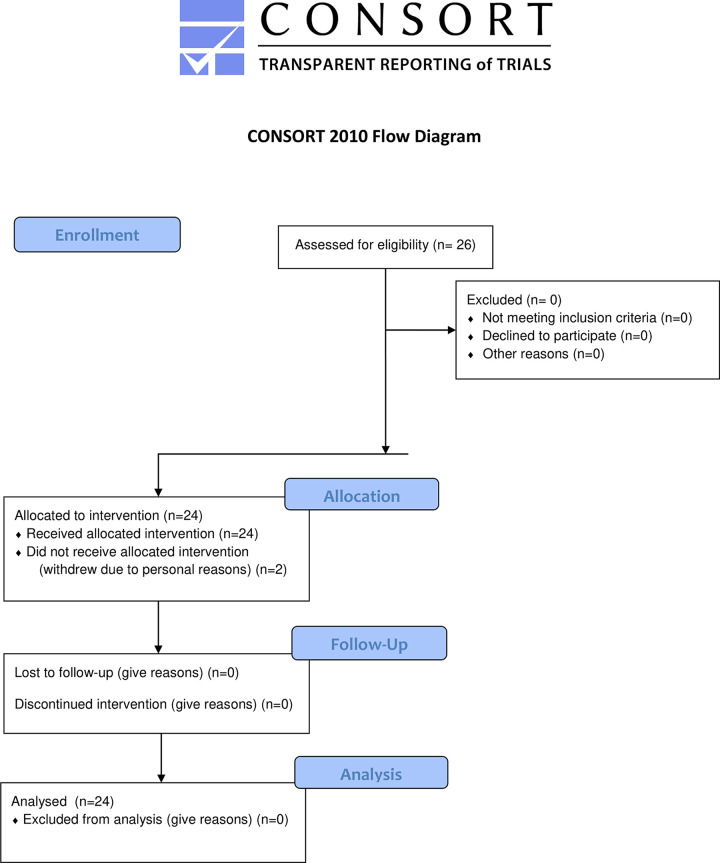
Consort flow diagram.